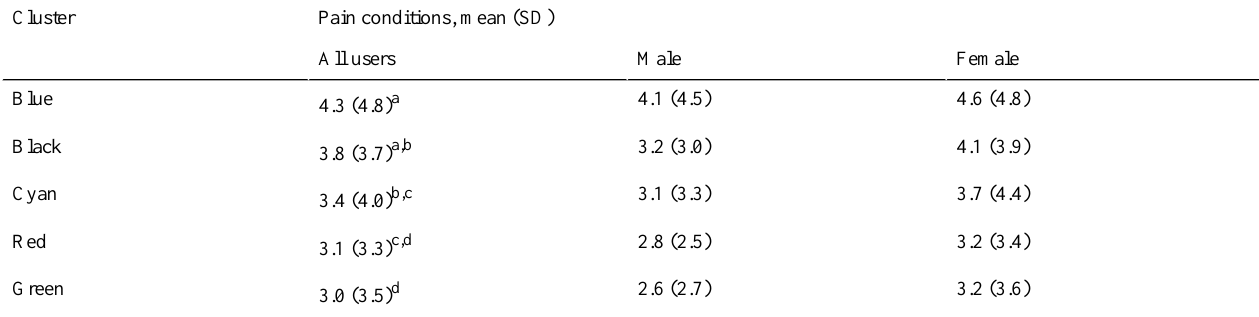
Table 3. Mean number of pain conditions for males and females in each cluster. Pain conditions, mean